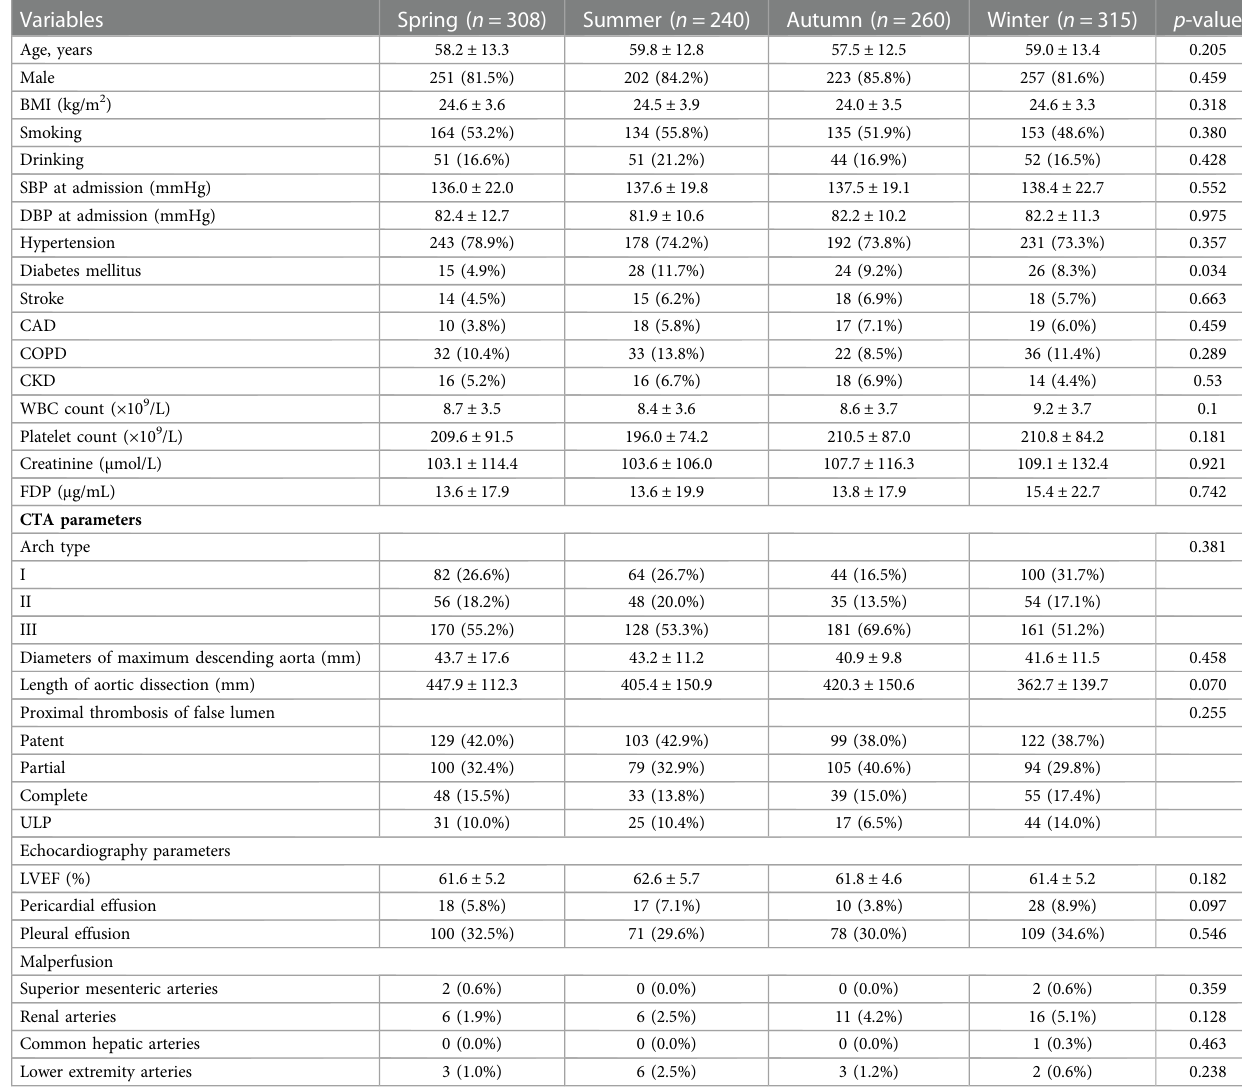
TABLE 1 Baseline characteristics of type B aortic dissection patients strati fi ed with seasons of thoracic endovascular aortic repair.